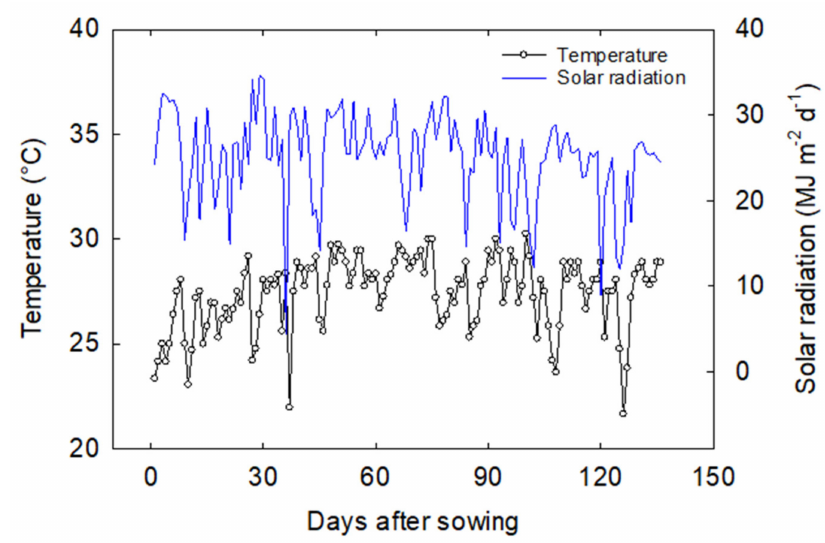
Figure 1. Temporal trends in average air temperature and daily solar radiation during the experimen- tal